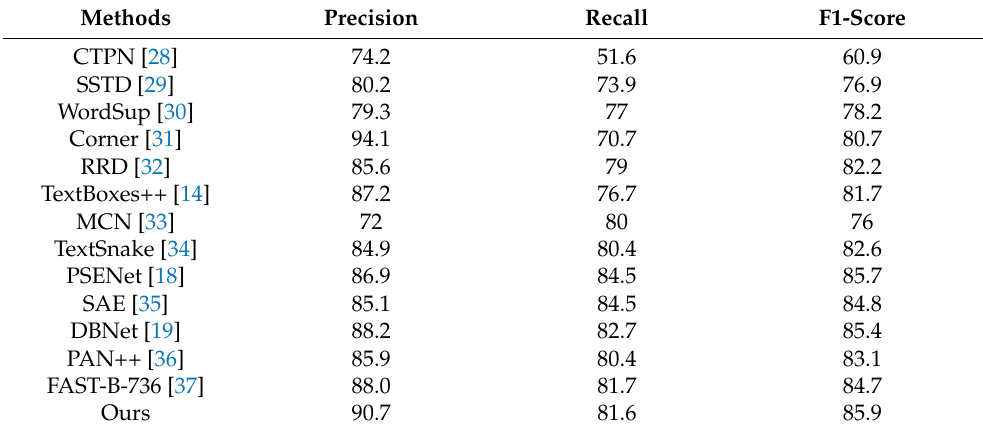
Table 1. Results of ICDAR2015 [25].